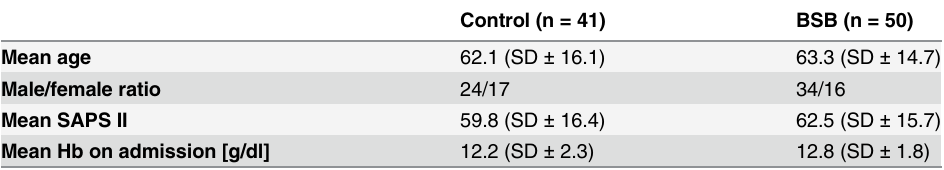
Table 1. Baseline characteristics of the patients included in the